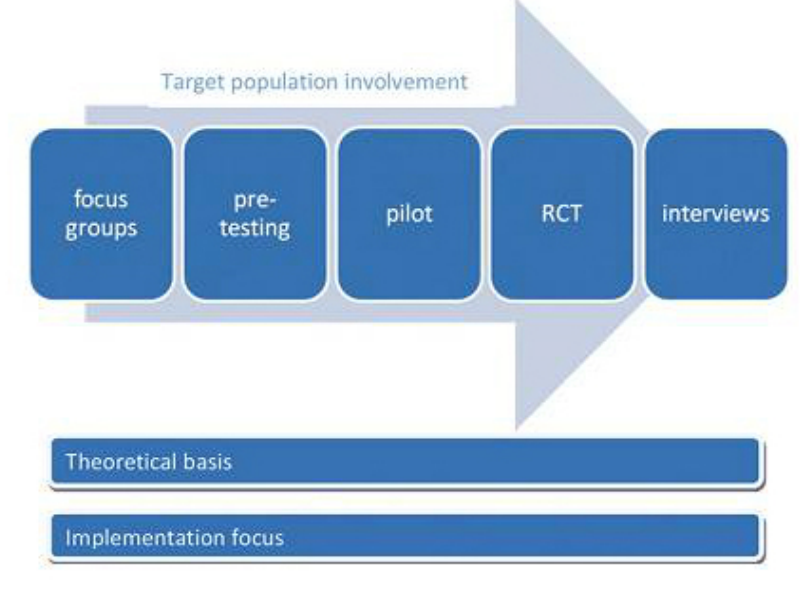
Figure 1. mHealth framework